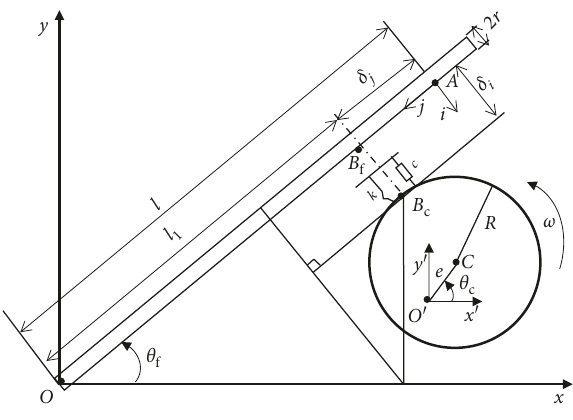
Figure 1: Schematic diagram of the cam-follower